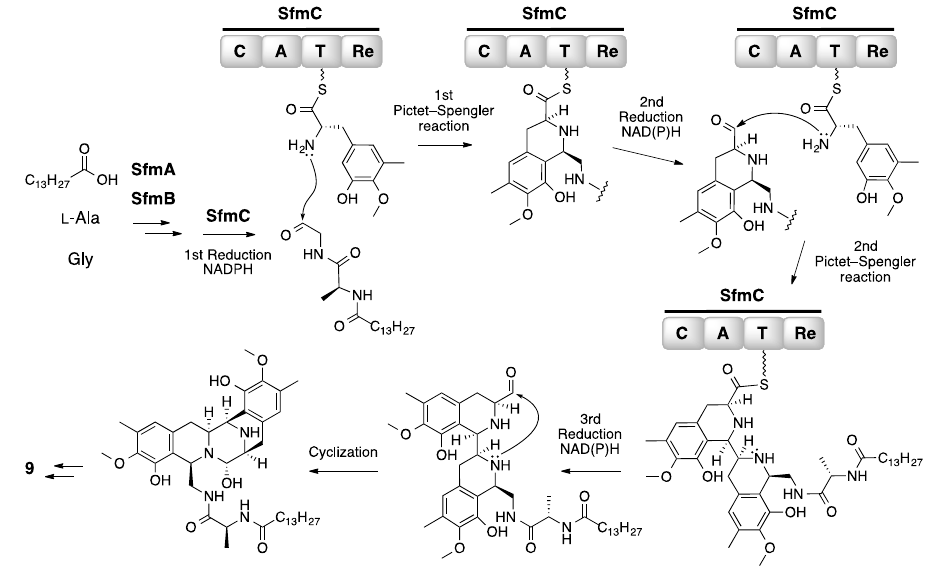
Figure 8. Proposed overall scheme for the pentacyclic core skeleton assembly during the biosynthesis of saframycin A 9 [35]. SfmA, SfmB and SfmC are three saframycin A nonribosomal peptide synthetases. C, condensation domain; A, adenylation domain; T, thiolation domain; Re, reductase domain.